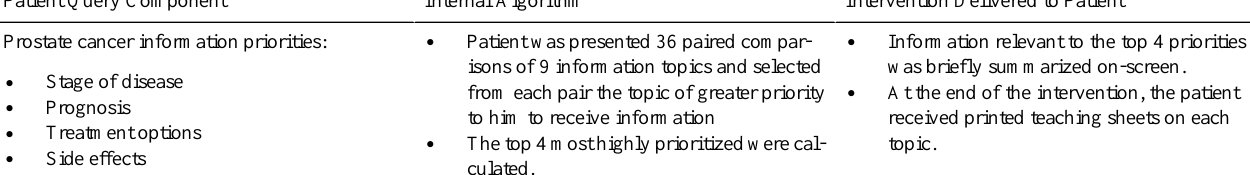
Intervention Delivered to PatientInternal AlgorithmPatient Query Component